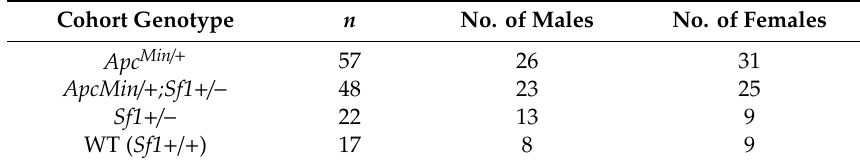
Table 1. Number of mice examined. Mice were siblings derived from parents Apc Min /+ and Sf1 +/ − .